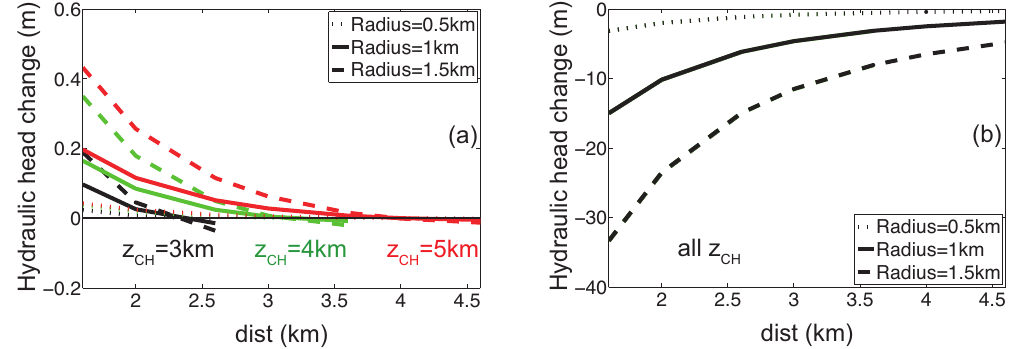
Figure 9. Influence of the geometry, i.e. chamber radius, chamber depth z CH , and distance (dist) between aquifer and chamber, on the initial central hydraulic head change. (a) pyroclastic aquifer, (b) lava flow aquifer.